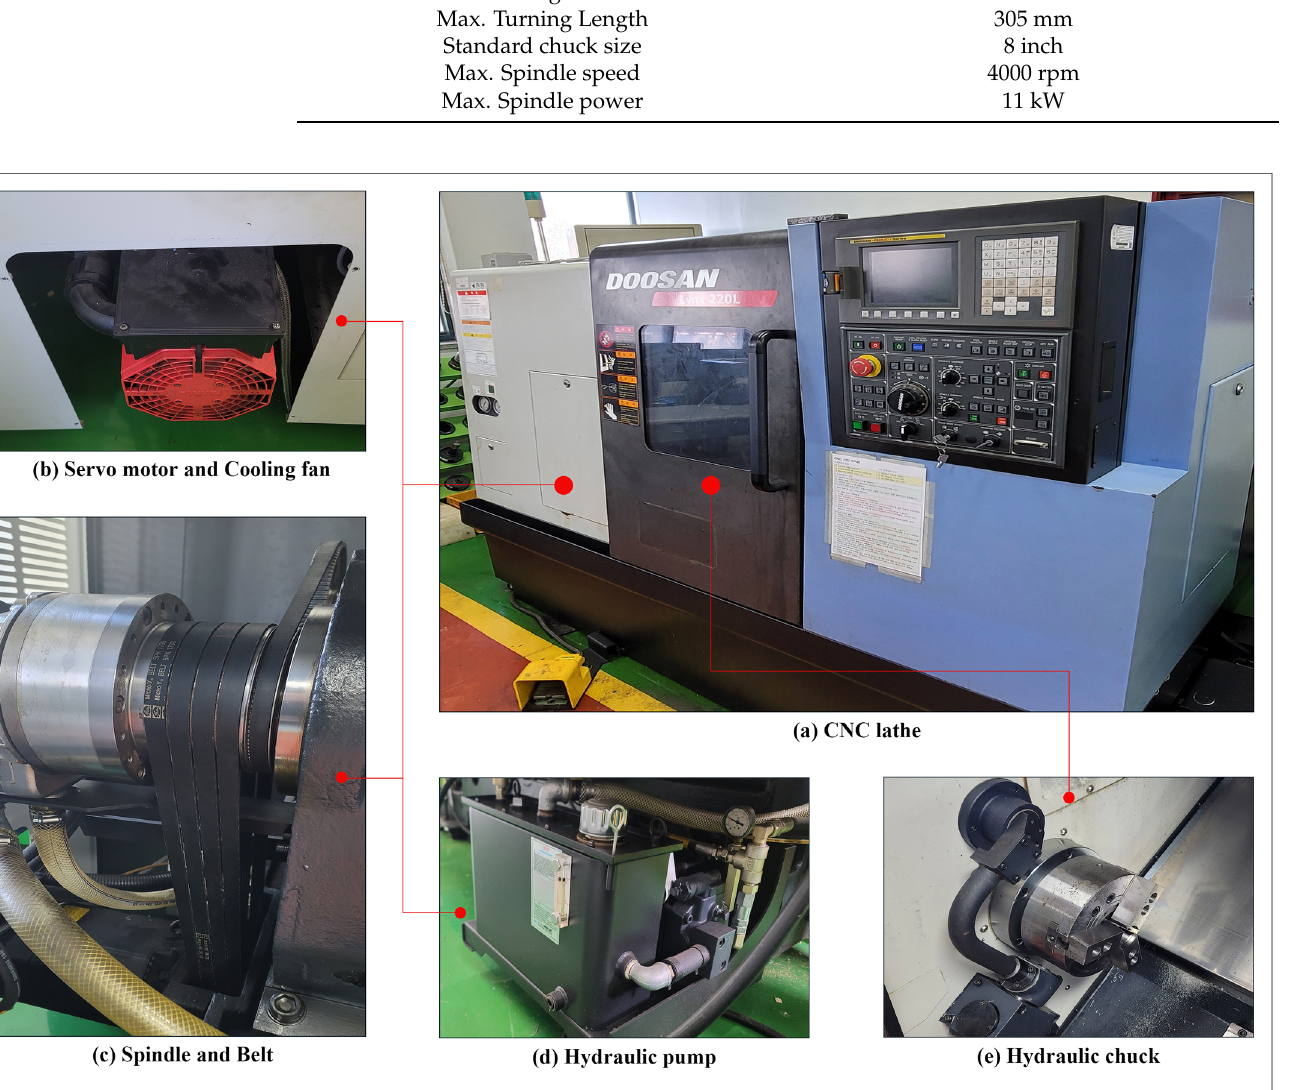
Figure 2. Major components of vibration in CNC lathes. ( a ) CNC lathe used in the experiment; ( b ) servomotor used to drive the spindle; ( c ) belt and main spindle connected to the servomotor to transmit power; ( d ) hydraulic pump used to operate the hydraulic chuck and tailstock; and ( e ) hydraulic chuck to hold the workpiece. Table 1. Specifications of the CNC lathe used in the experiment.